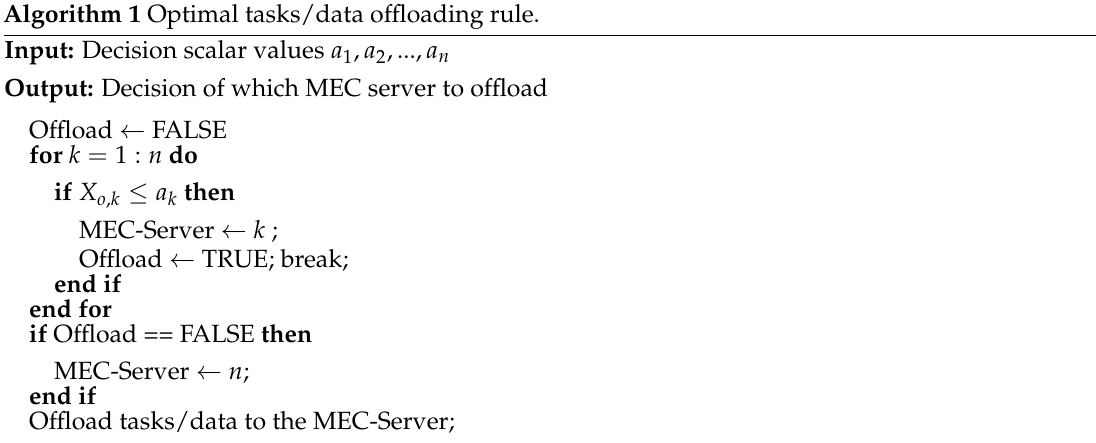
Algorithm 1 Optimal tasks/data offloading